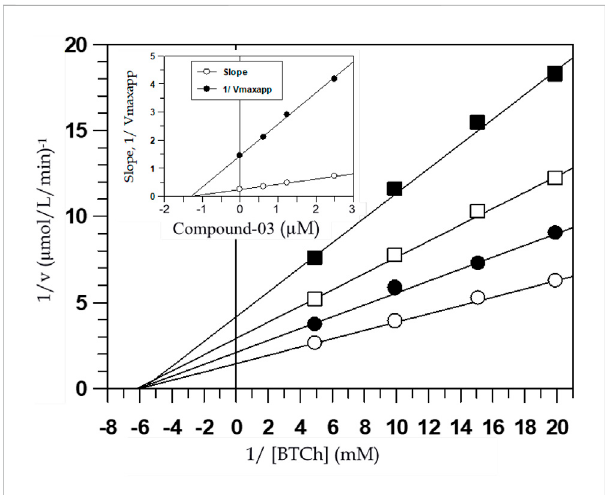
FIGURE 2 Lineweaver-Burkplotofreciprocals oftheinitial velocities versus reciprocals of BTCh in the absence ( ○ ) and presence of 1.25 µM ( C ), 2.5 µM ( □ ) and 5 µM ( ■ ) of compound-03 against BChE. Inside frame shows the secondary replots of the Lineweaver-Burk plot: 1/ V maxapp or Slope versus various concentrations of inhibitor,